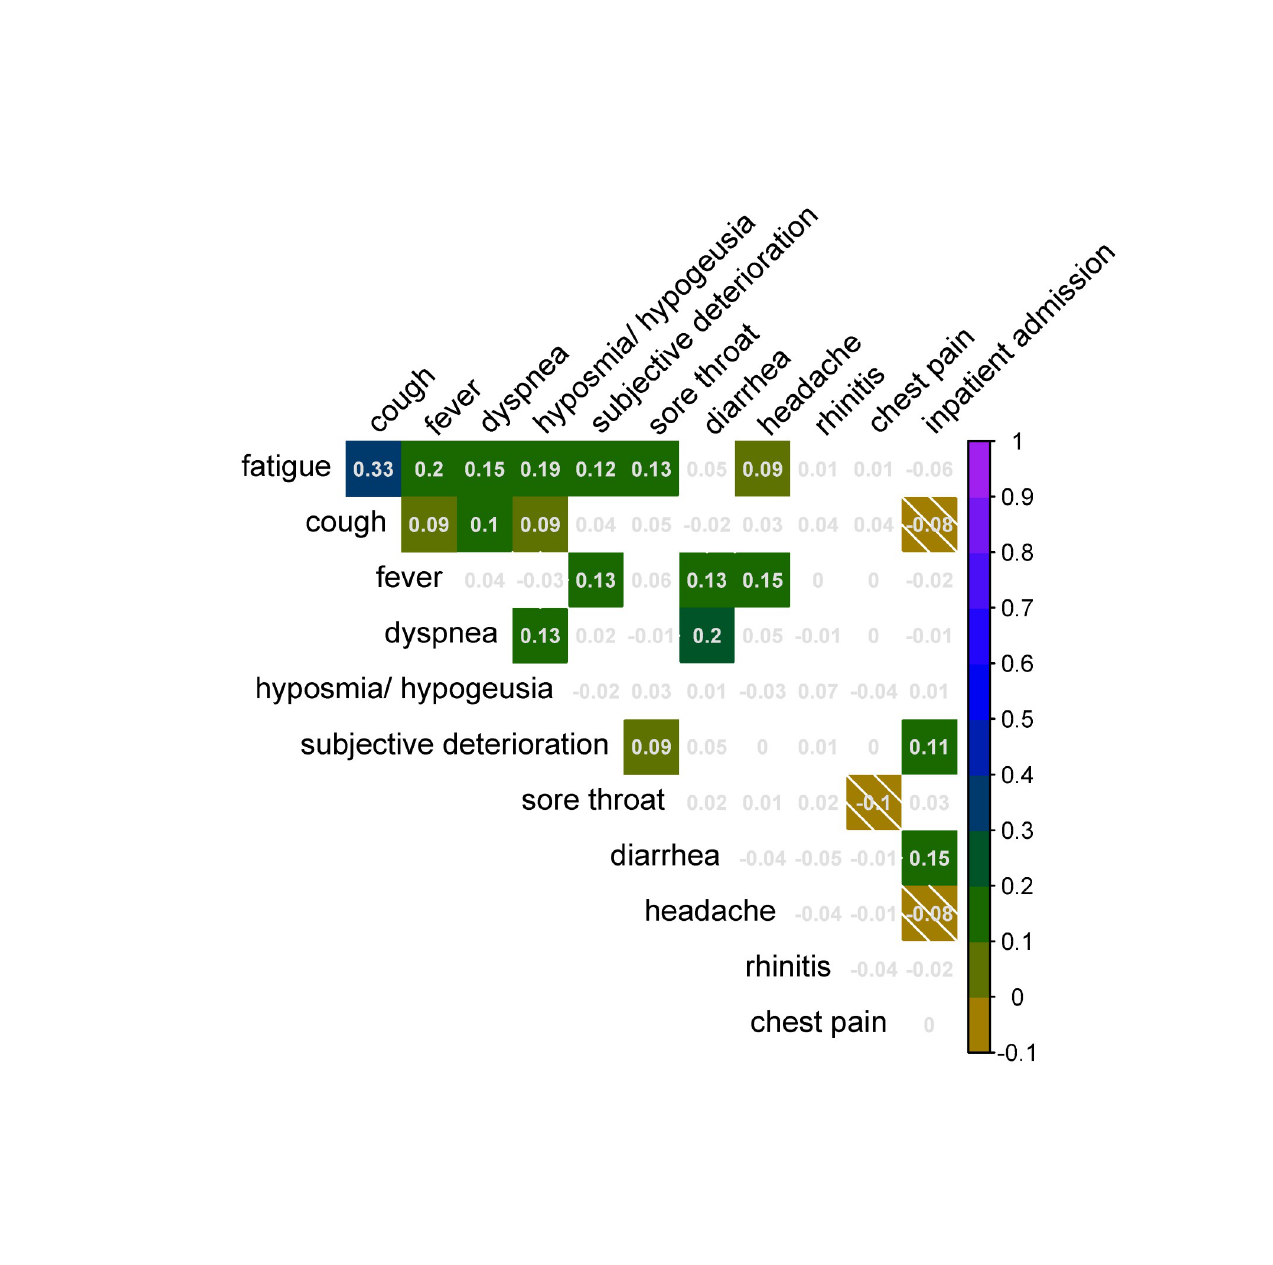
Fig 6. Positive and negative correlation of symptoms observed in individual patients. Shown are all pairwise correlations, significant correlations are indicated by a background color (FDR � 0.05). Color codes in the color bar represent the size of the correlation coefficient r. Anti-correlation of symptoms (r � 0) is emphasized with diagonal